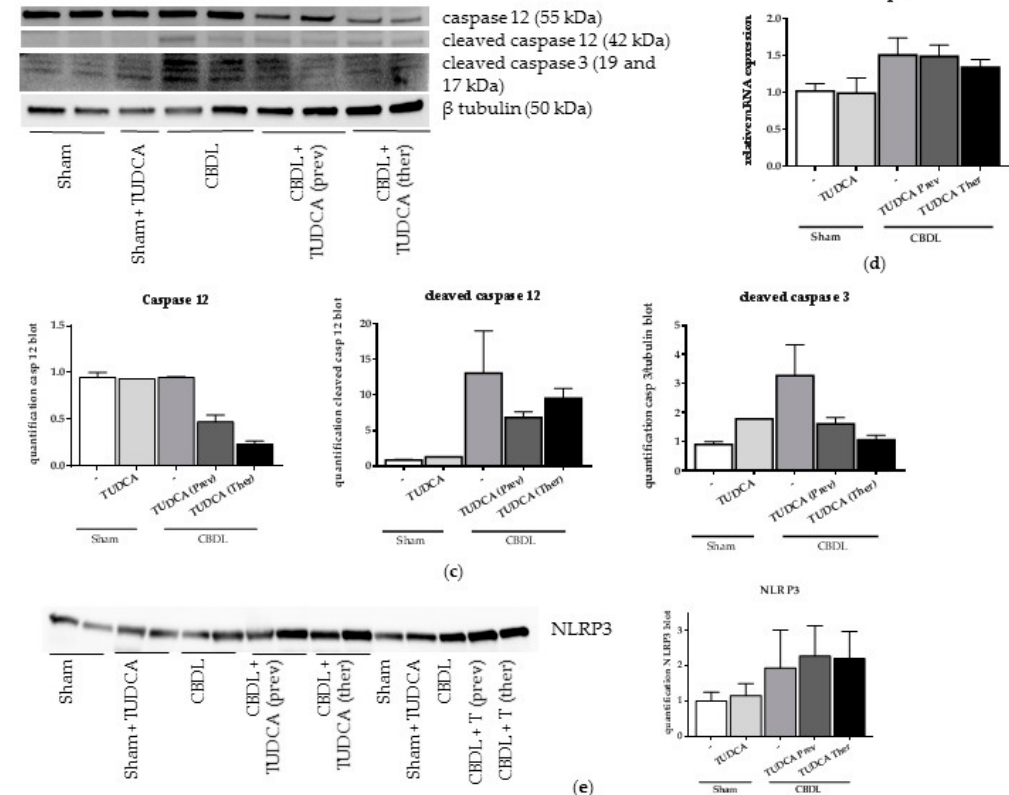
Figure 4. Treatment with TUDCA reduces CBDL-induced CHOP and pro-apoptotic markers. ( a ) Representative Western blot of CHOP on whole liver lysates. β -Tubulin was used for normalization. Quantification of CHOP blot compared to β -tubulin bands. Samples of three to five mice per group were mixed for blotting; ( b ) Real-time qPCR analysis of pro-apoptotic genes caspase 3 and 12, TNFRSf1a, FADD and Bcl2. Data are presented as mean ± SD. * p < 0.05, ** p < 0.01, *** p < 0.001; ( c ) Western blot and quantification of cleaved caspase 3 and cleaved caspase 12 on whole liver lysates. β -Tubulin was used for normalization. One to two samples per group were loaded with one sample consisting of a mixture of two mice; ( d ) Real-time qPCR analysis of pro-pyroptotic marker caspase 1. Data are presented as mean ± SD; ( e ) Western blot of NLRP3 on whole liver lysates. Quantification of NLRP3 was normalized to total protein load. Three samples per group were loaded with one sample consisting of a mixture of two mice, so a total of six mice were analyzed.